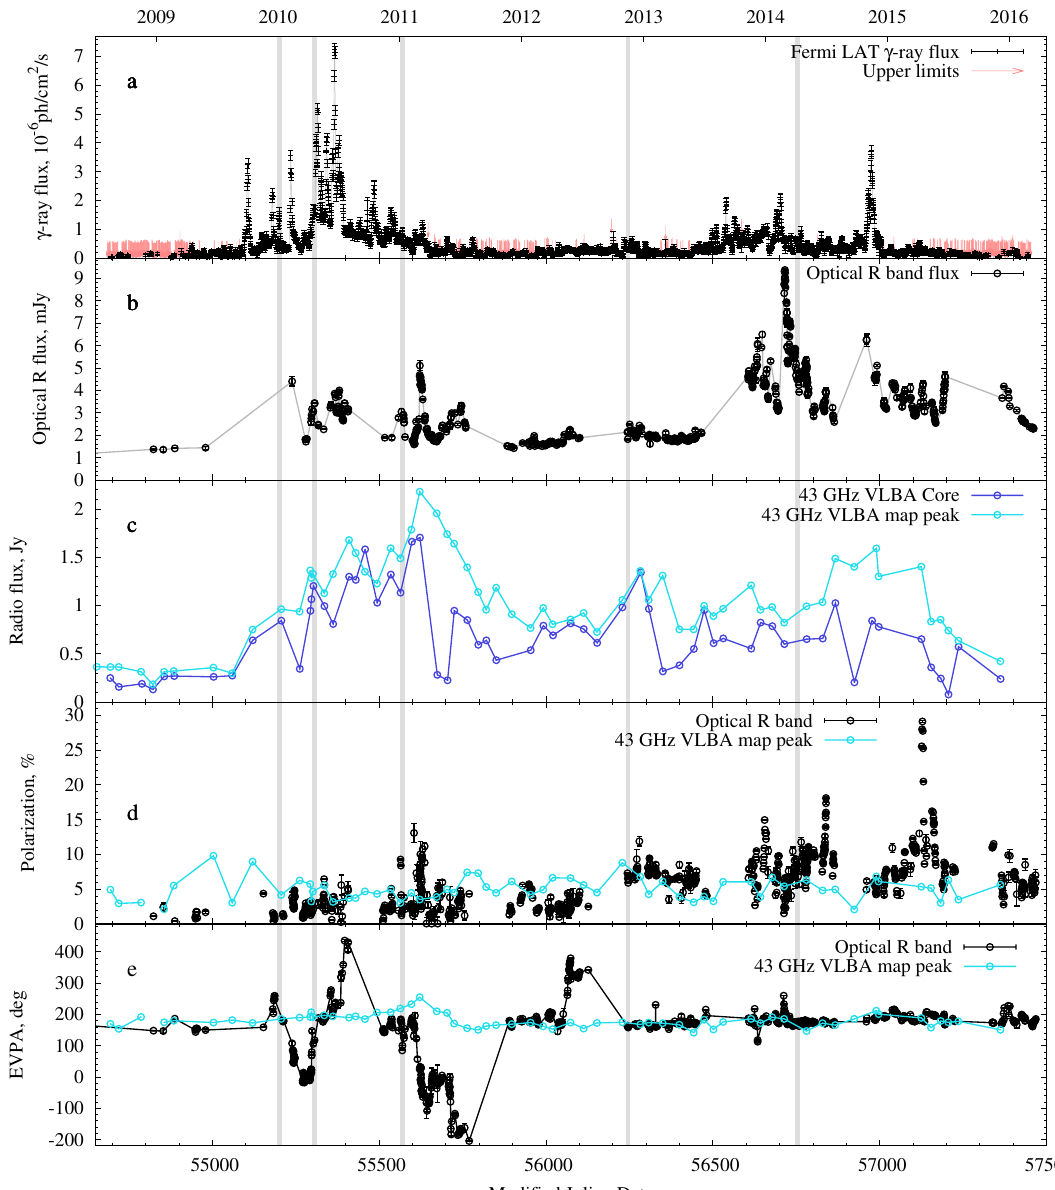
Figure 1. Light curves and polarization parameter curves. ( a ) Fermi LAT 0.1–200 GeV γ -ray light curve. Red arrows mark upper limits (test statistic values <10; i.e., less than ∼ 99.7% confidence level); ( b ) Optical light curve in R band; ( c ) Light curves in the 43 GHz radio band of the VLBI core and Very Long Baseline Array (VLBA) map peak; ( d ) Degree of polarization of the 43 GHz VLBA map peak and optical R band; ( e ) EVPA of the 43 GHz VLBA map peak and optical R band. The vertical gray bars mark ejection times of knots